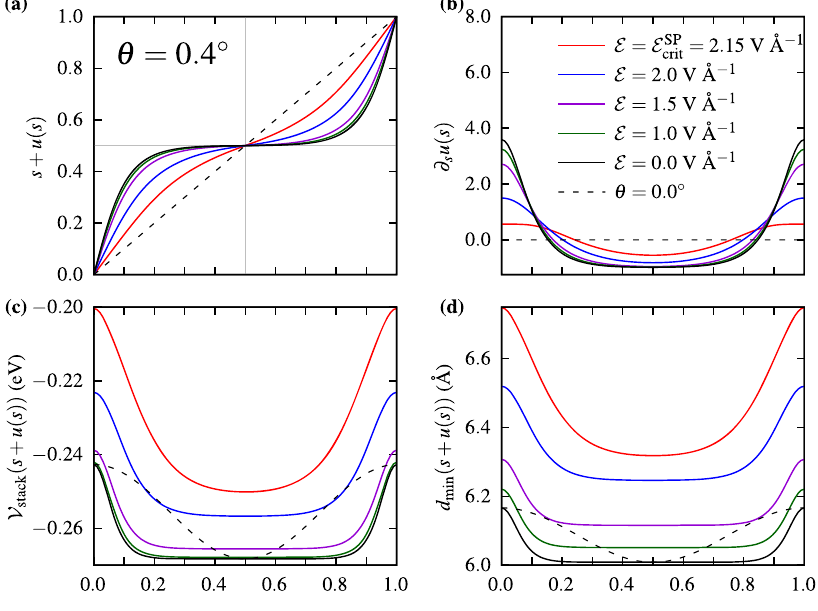
Fig. 3 Lattice relaxation from the 1D FK model, including the quadratic electrostatic term. a Total displacement in con fi guration space s + u ( s ), b gradient of displacement ∂